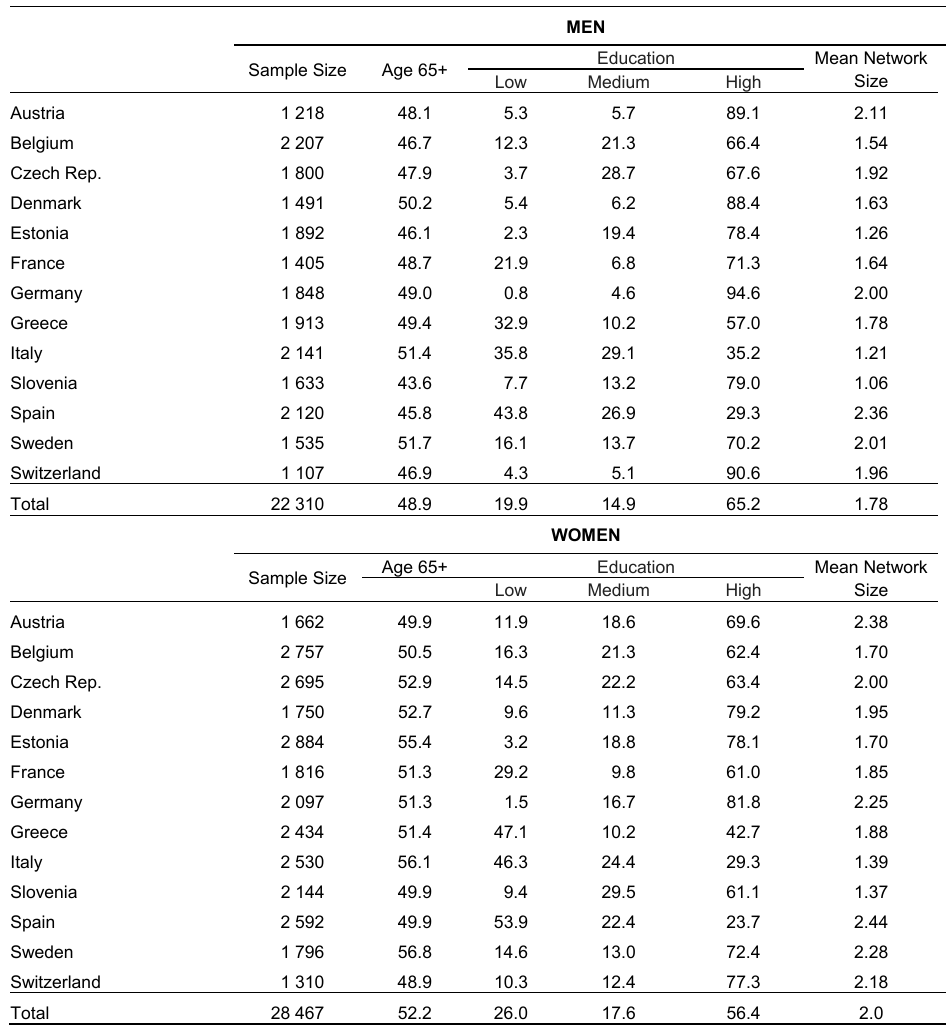
Table 2 : Sample size and descriptive statistics of the control variables for the pooled sample and across 13 European countries. Individuals aged 50-85 years MEN Education Mean Network Sample Size Age 65+ Size